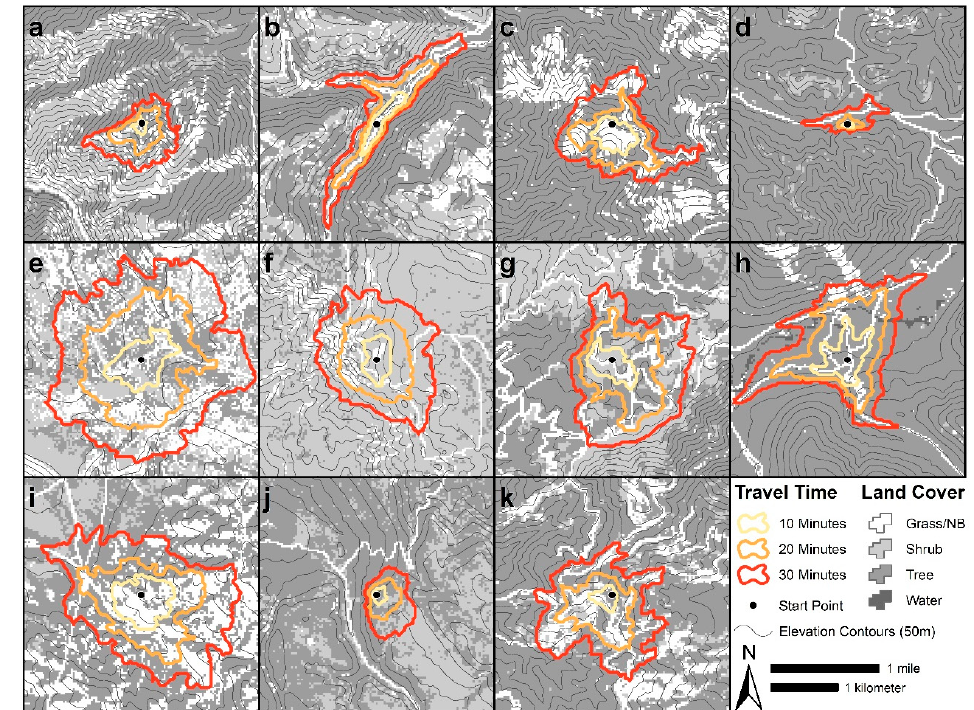
Figure 11. Simulated travel time results from several recent wildland firefighter entrapment incidents used as the basis for ERI evaluation: ( a ) Cramer (2003); ( b ) Little Venus (2006); ( c ) Panther (2008); ( d ) Horseshoe 2 (2011); ( e ) Holloway (2012); ( f ) Yarnell (2013); ( g ) King (2014); ( h ) Liberty (2017); ( i ) Preacher (2017); ( j ) Horse Park (2018); and ( k ) Ranch (2018).